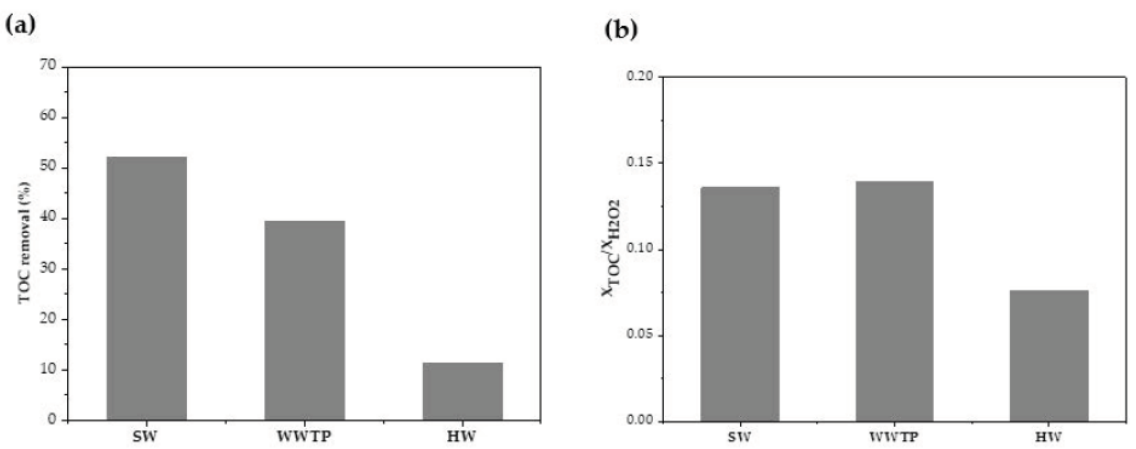
Figure 10. ( a ) TOC removal percentage and ( b ) H 2 O 2 removal efficiency values for treating the three environmentally relevant water matrices by CWPO.